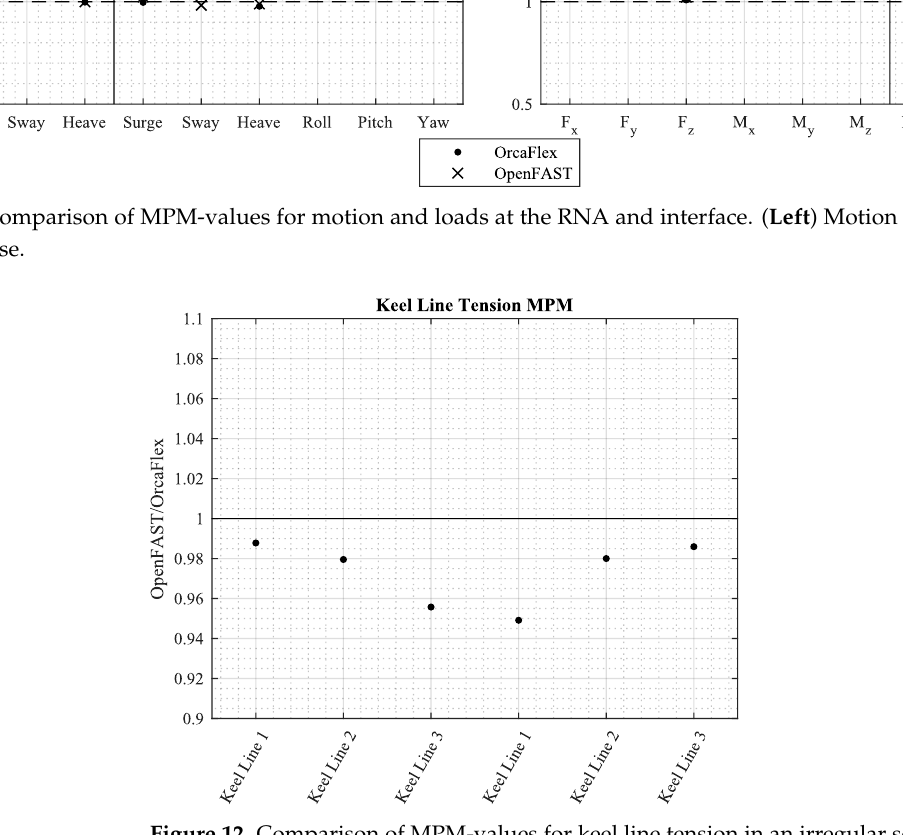
Figure 12. Comparison of MPM-values for keel line tension in an irregular sea